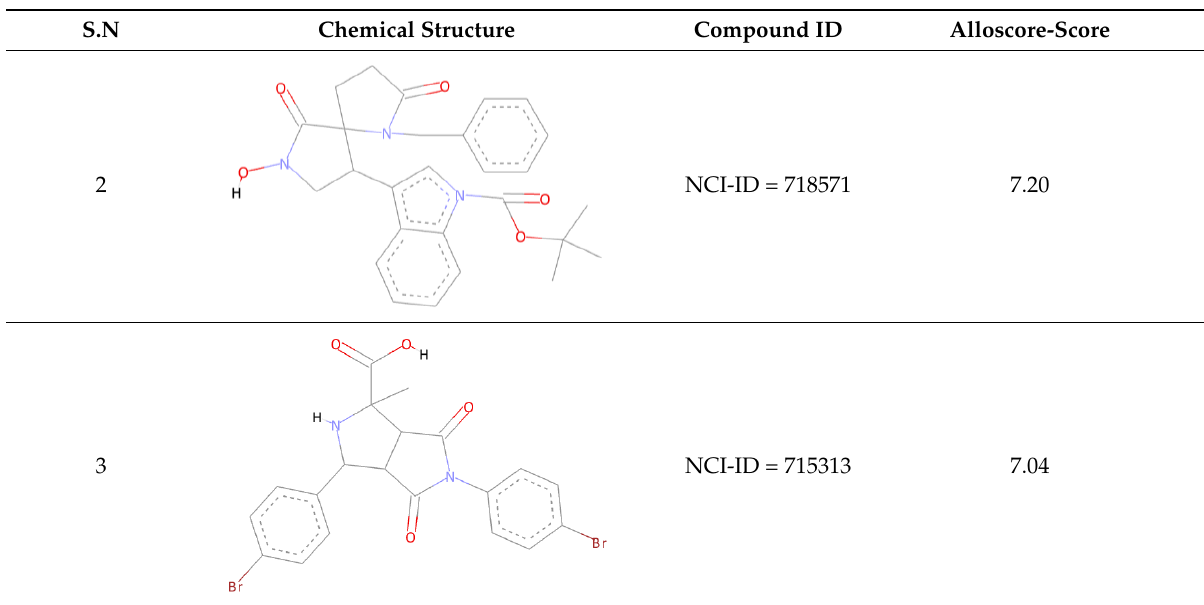
Figure 7. Secondary structure elements (SSE), white color — loops, red color — helix regions, turquoise color — strands in the protein. 4.2. MD Analysis of the SARS-CoV-2 NSP10/NSP16 MTase and CHEMBL2229121 Complex Molecular dynamics simulation studies of this complex revealed that it was stable during the 100 ns virtual simulation time. The RMSD and the RMSF values of the complex can be seen in Figure 8. The trajectory analysis of this complex for the interaction of this ligand with the allosteric site showed that this compound had various types of contacts during the 100 ns time. The water-bridged assisted hydrogen bond interactions were the most prominent, followed by the conventional hydrogen bonding of the allosteric ASP130 and TYR132 residues. The PHE149 also made hydrophobic interactions with the allosteric site of SARS-CoV-2 MTase, and the ASP99 and GLY73 allosteric residues also made hydrogen bond contacts with the allosteric site, as shown in the protein-ligand histogram diagram in Figure 9A. As seen in the Allofinder studies in the previous sections, this ligand retained and showed the same interactions in the MD studies. The intensity of each of the allosteric residues with this ligand is shown in Figure 9B,C, where GLY71, GLY73, ASP99, ASN101, ASP130, and TYR132 allosteric residues were in constant contact with the allosteric site of the SARS-CoV-2 MTase along the 100 ns simulation trajectory.